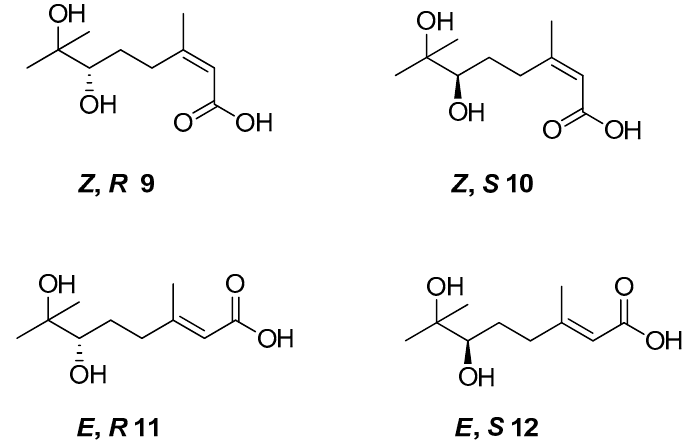
Figure 4. Geraniol-based phenols/methoxyphenols.